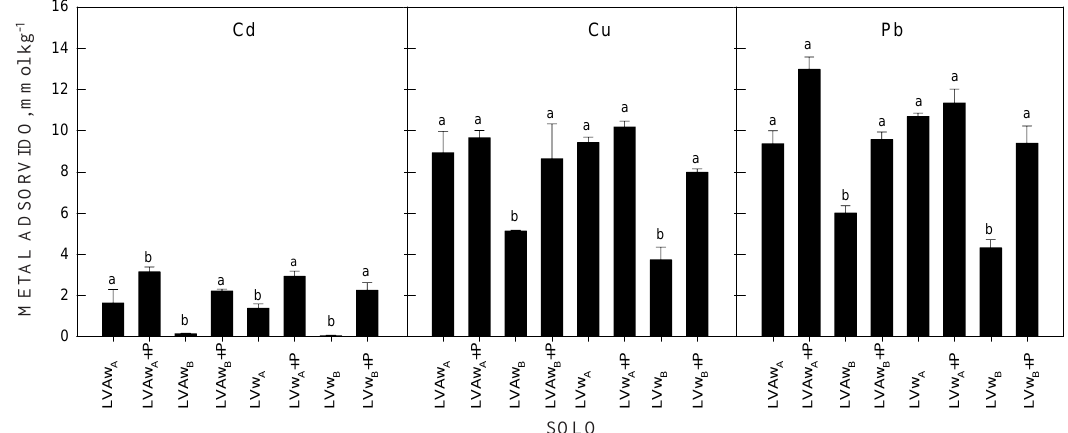
Figura 1. Quantidade adsorvida dos metais Cd, Cu e Pb por amostras de Latossolos, tratadas e não tratadas com fósforo, suspensas em Ca(NO para reagir, individualmente, com Cd(NO final 1:100). (LVAw = Latossolo Vermelho-Amarelo ácrico típico; LVw = Latossolo Vermelho ácrico típico; os índices A e B indicam os horizontes e P as amostras tratadas com fósforo). Colunas seguidas da mesma letra, para um mesmo metal, não diferem entre si pelo teste de Scott-Knott a 5 %. Barras acima das colunas indicam o erro-padrão da média (n =